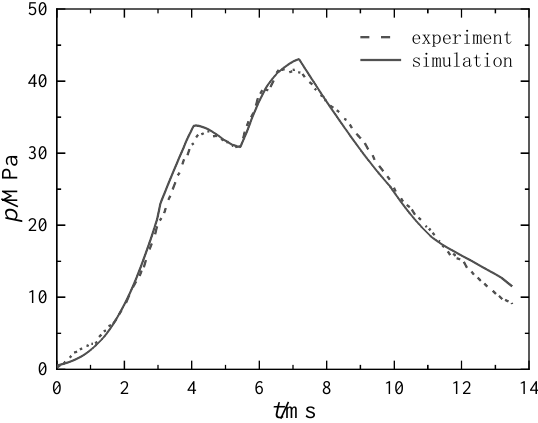
Figure 4. Chamber pressure of the gas-curtain launcher.